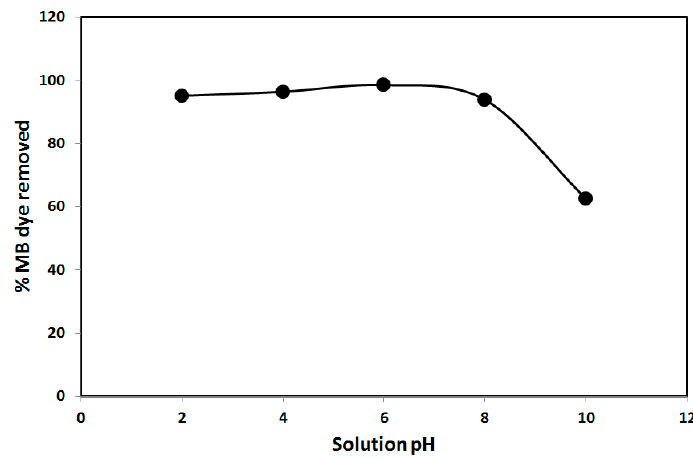
Figure 6. Effect of solution pH on the percentage of methylene blue dye removed from an aqueous solution by SNCM.